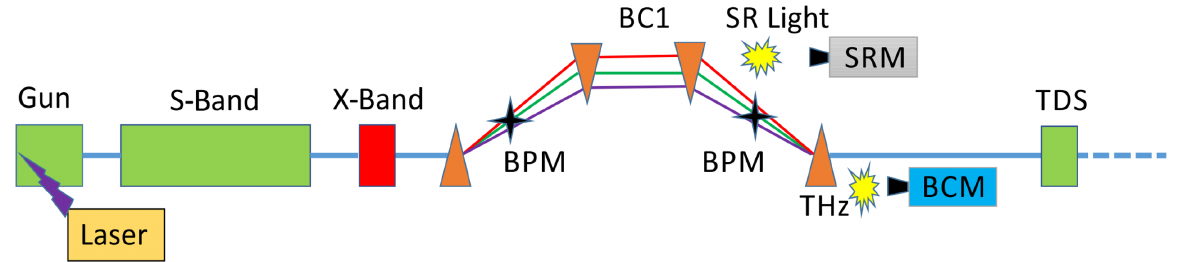
FIG. 3. Sketch of the SwissFEL injector: rf structures, magnetic chicane and main beam